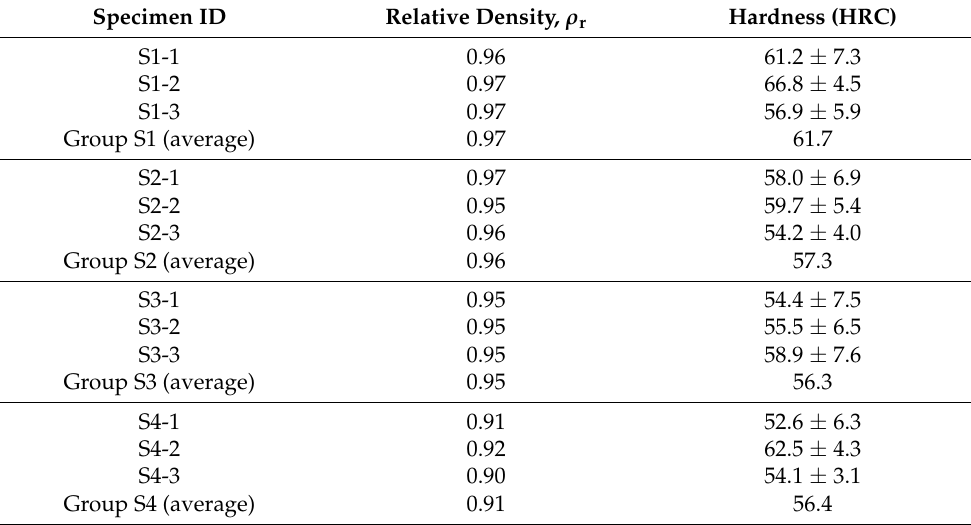
Table 3. Density and hardness of SLM AISI 420 built with various laser spot